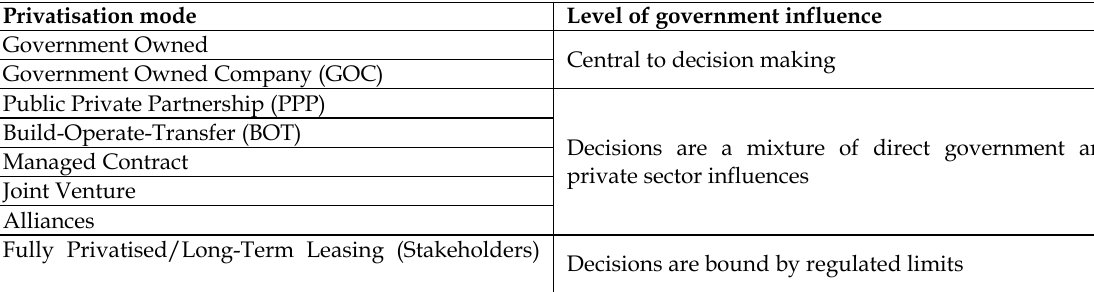
Table 2. Modes of airport